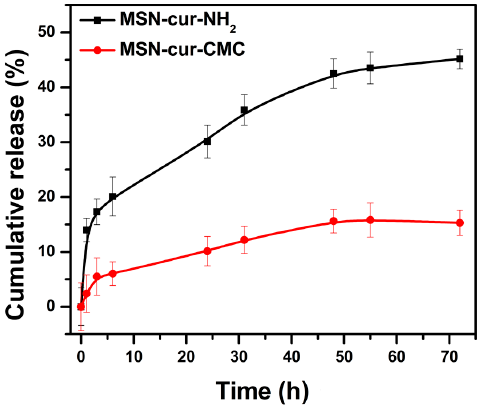
Figure 5. In vitro cumulative release (%) of curcumin from MSN-cur-NH 2 and MSN-cur-CMC in 0.5% sodium lauryl sulphate (SLS).